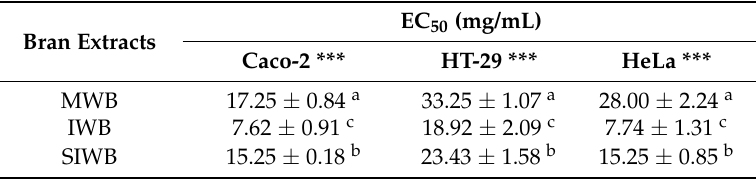
Table 3. EC 50 values of antiproliferative activity of cells treated with mature, immature, and steamed immature wheat bran